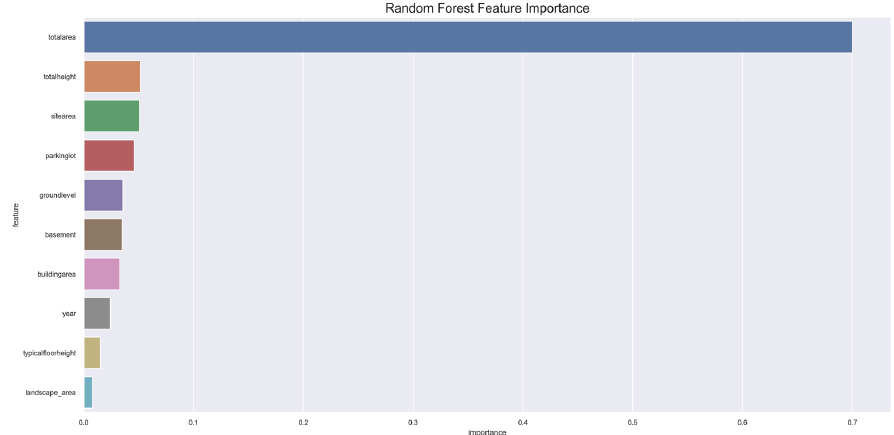
Figure 5. Feature Importance.